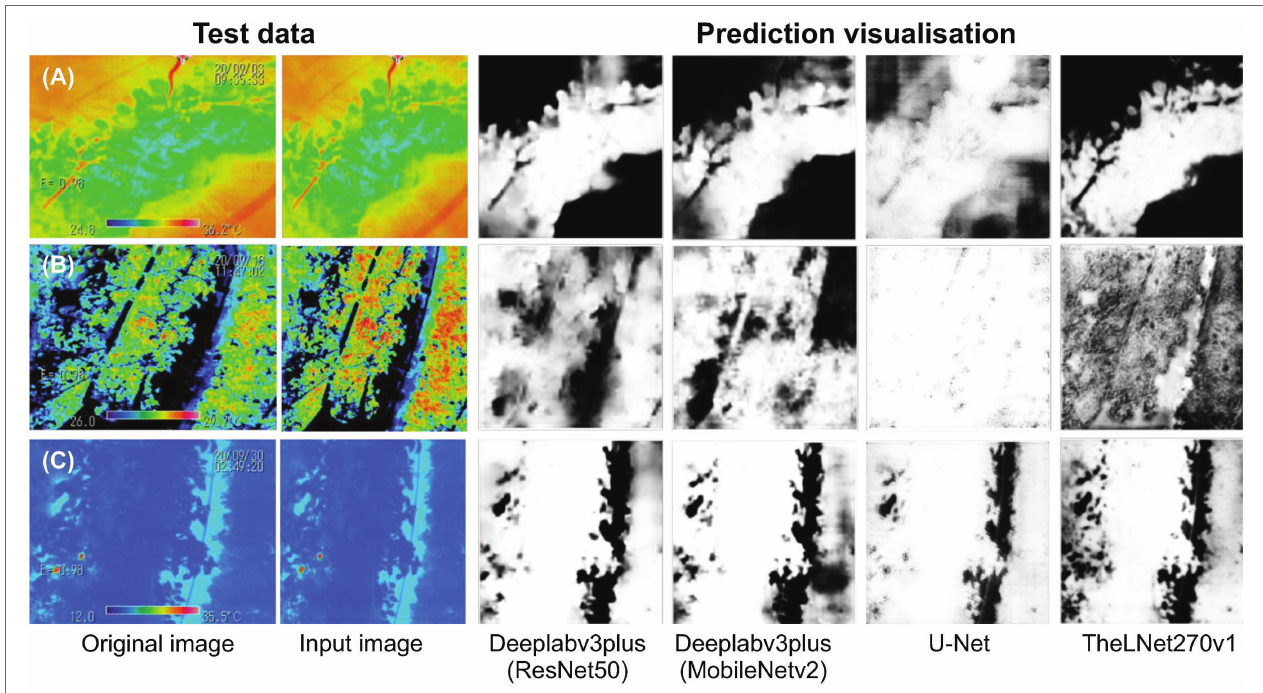
FIGURE 14 | Prediction visualization of the single independent test image. (A) The early morning with a sunny condition. (B) The midday with a sunny–cloudy condition. (C) The midnight condition.